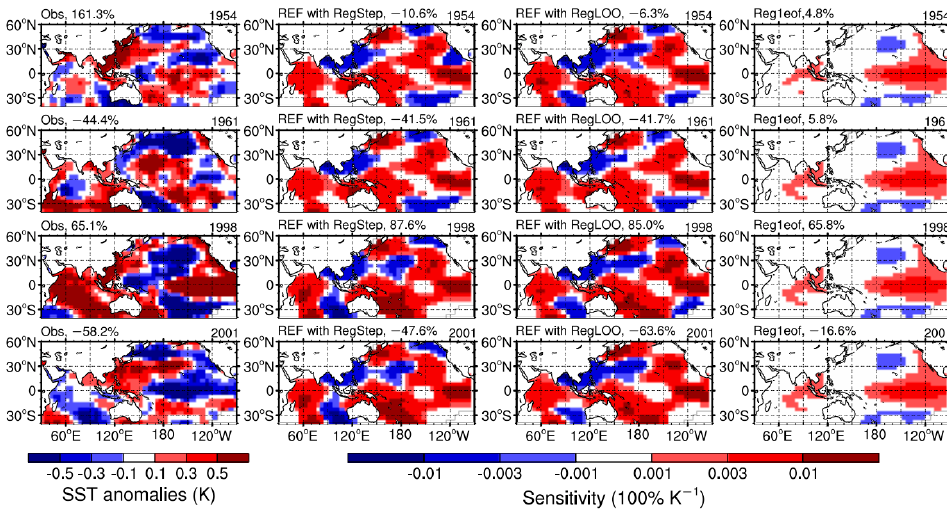
Figure 5. The prophase SST anomalies in four years ( left panel ) and the forecast model sensitivities of the corresponding year ( right panel ). The experiment name, precipitation percentage anomaly, and year are shown at the top of each graph.